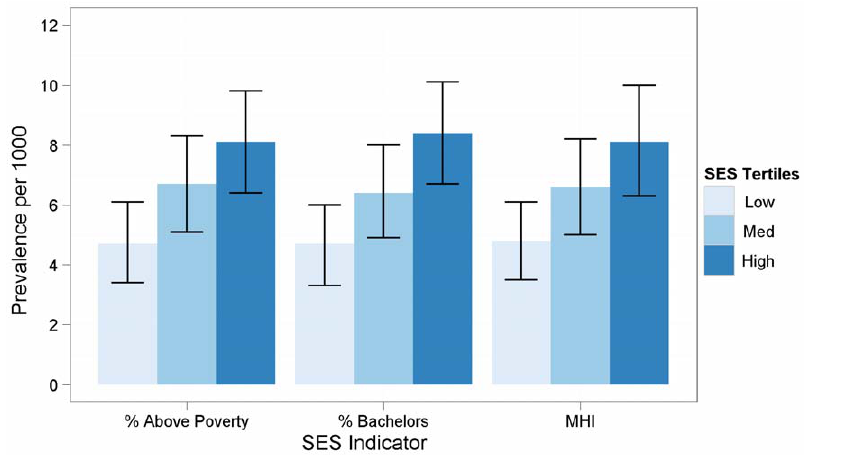
Figure 1. Prevalence per 1000 1 of ASD by three SES indicators based on census block group of residence. 1 Thin bars indicate 95% confidence intervals. Within each SES indicator, both the trend test and x 2 tests were significant at p , 0.0001. 2 MHI refers to median household income. doi:10.1371/journal.pone.0011551.g001 PLoS ONE |